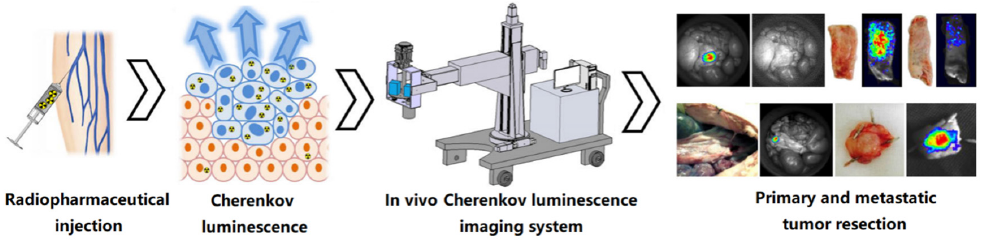
Figure 3. Schematic overview of the in vivo Cherenkov luminescence image ‐ guided surgery. Adapted with permission from Ref. [116] 2019 John Wiley and Sons.